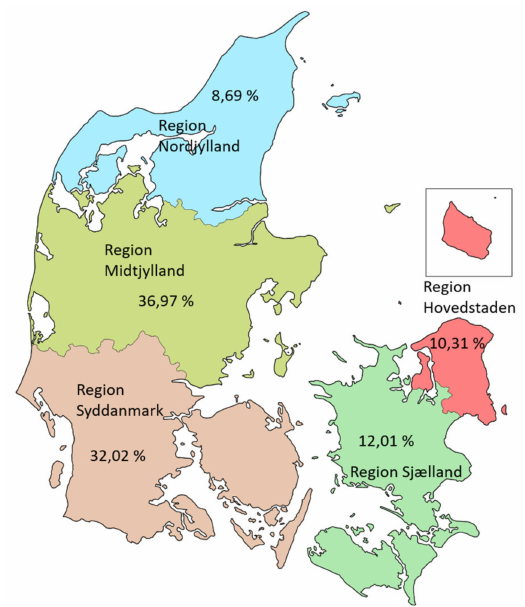
Figure 5. The percentage of the GPS data currently available at the main regions of Denmark (Adapted from reference